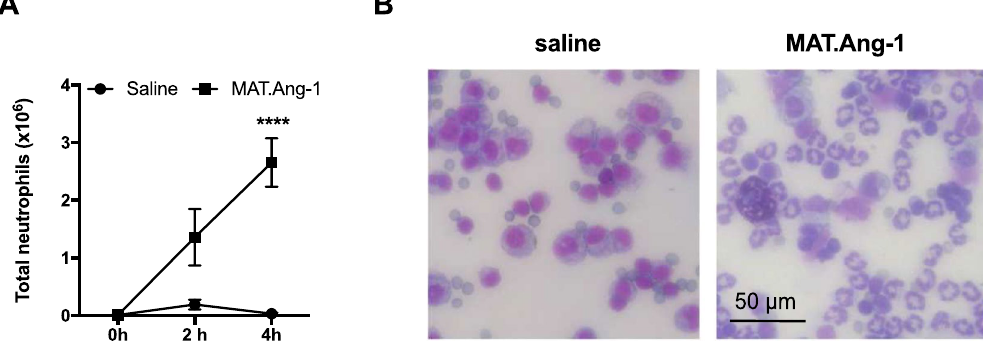
Figure 3. Neutrophil migration in response to MAT.Ang-1 in vivo . MAT.Ang-1 (33 µ g/mouse) or saline control were injected i.p. into C57/Bl6 mice. After 0–4 h peritoneal lavage was performed and the total neutrophil count was calculated using total leukocyte and differential counts. ( A ) Results are presented as mean ± SEM (n = 3–5 mice) and analysed for statistical significance using two-way ANOVA followed by Bonferroni’s test for multiple comparisons. *** P < 0.001. ( B ) Cytospins were performed using lavage samples taken at 4 h. Hema Gurr ® was used to stain and images were taken at × 200 magnification. Scale bar = 50 µ